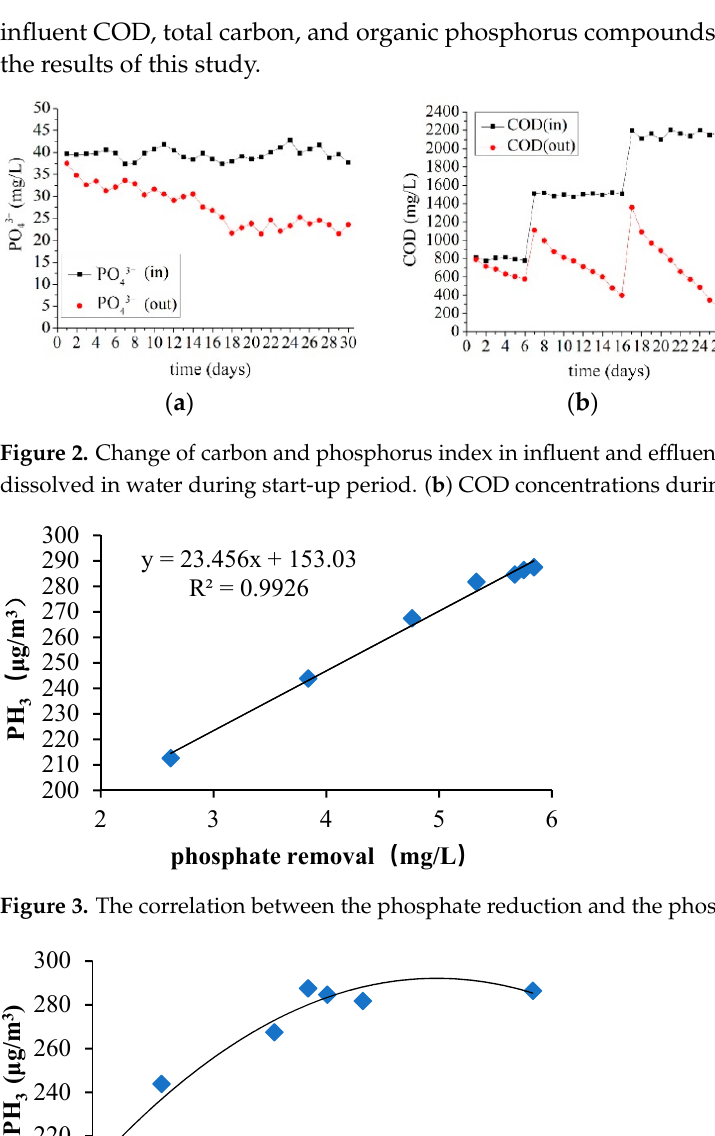
Figure 3. The correlation between the phosphate reduction and the phosphine production.